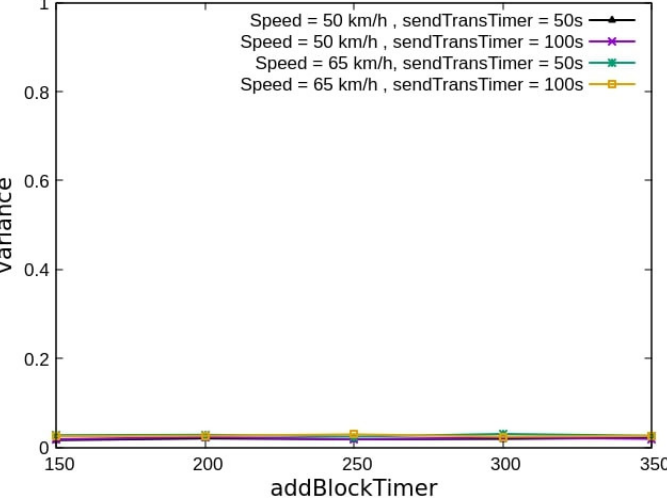
Figure 9. The variance of the trust metrics for non-malicious vehicles vs. addblockTimer (s).